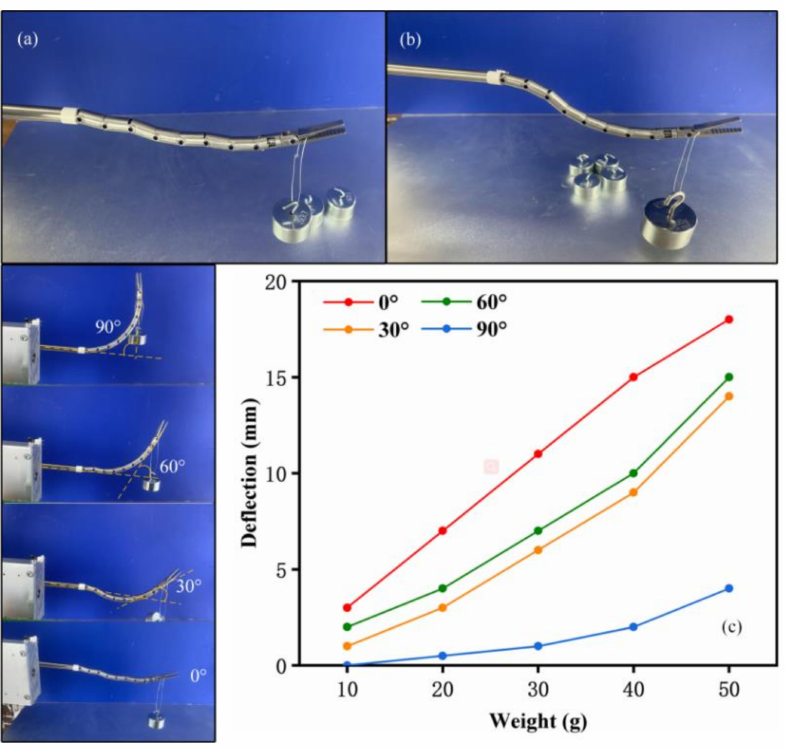
Figure 13. Experiments on the bending motion under load: ( a ) small weights; ( b ) extreme condition; ( c ) deflections caused by the small weights.